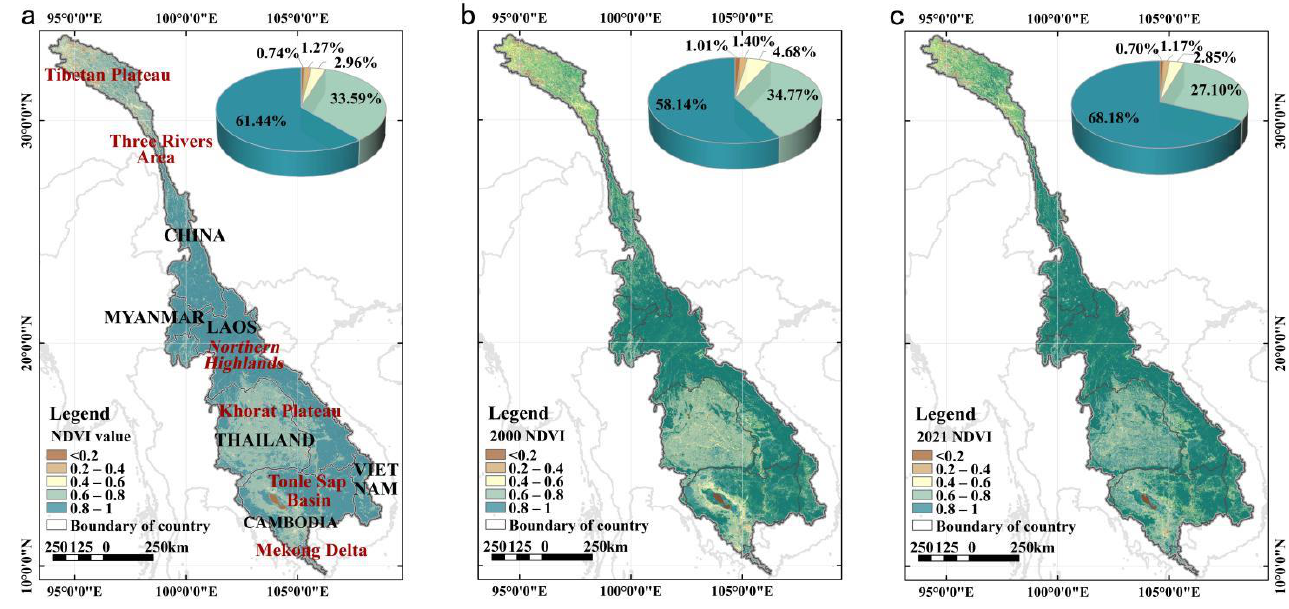
Figure 4. Spatial distribution of NDVI in the LMRB. ( a ) Average annual NDVI; ( b ) 2020 NDVI; ( c ) 2021 NDVI.